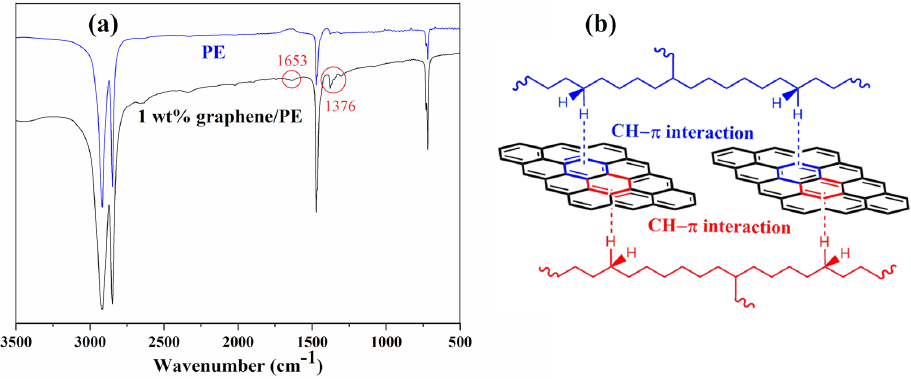
Figure 1. ( a ) FTIR spectra and ( b ) CH– π interactions between graphene and